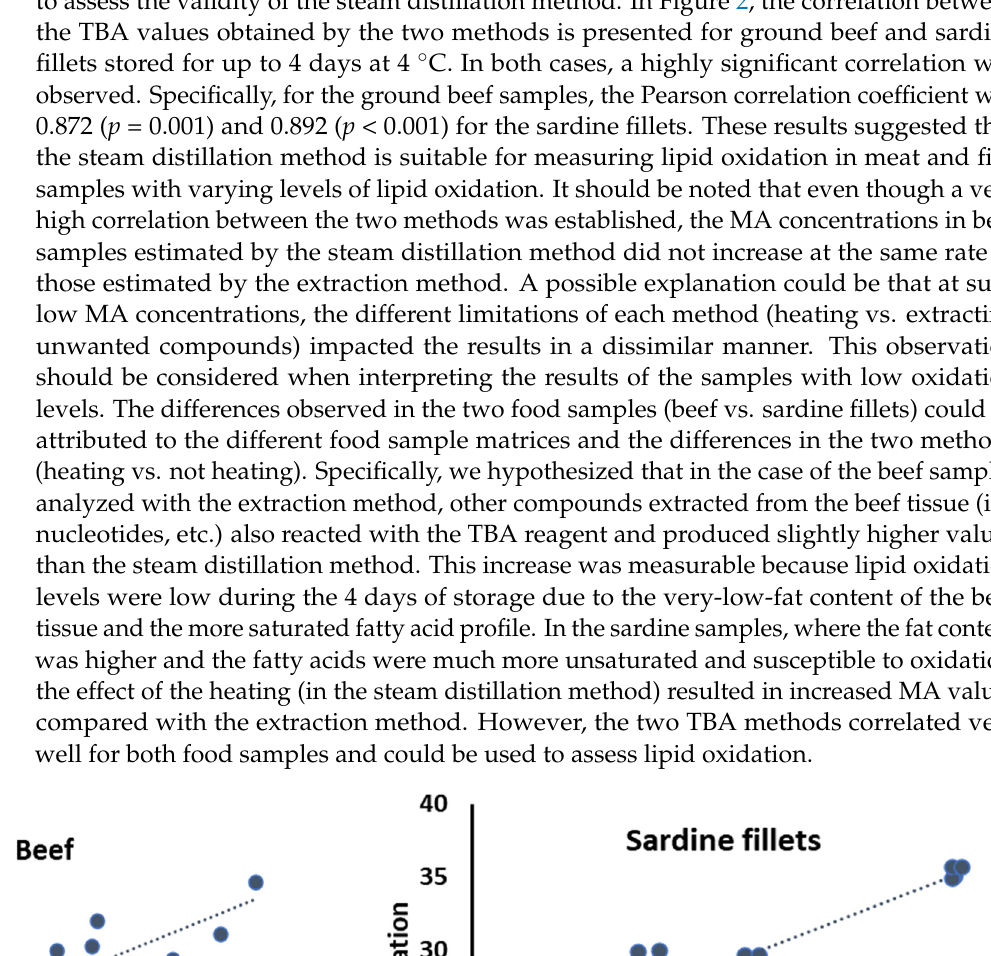
Figure 1. Standard curve of malonaldehyde for the steam distillation TBA method.